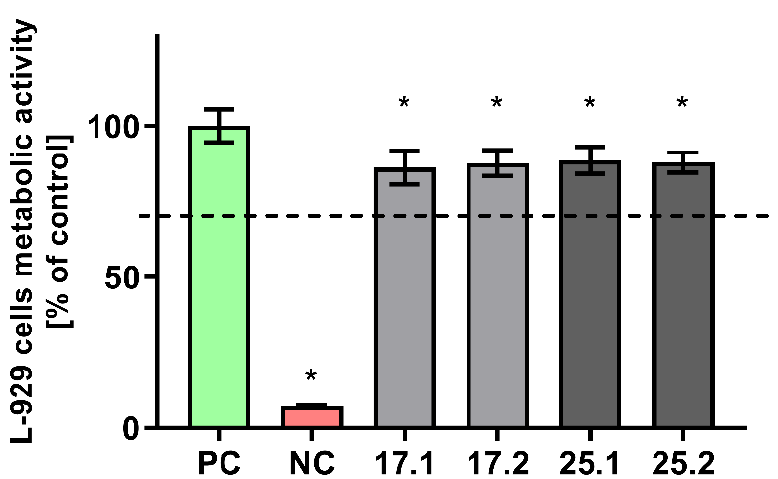
Figure 8. The viability of murine fibroblasts (L-929) after 24 h incubation with biocomposites, evaluated using MTT reduction test according to ISO-10993-5:2009. The positive control (PC) of the viability (100%) consisted of cells incubated without composites. The negative control (NC) of the viability (cells with significantly impaired metabolic activity) consisted of cells incubated with 0.3% hydrogen peroxide. The data are presented as mean ± SD, n = 6. The dashed line indicates the minimum level (70%) of the cells’ metabolic activity required to recognize the biomaterial as noncytotoxic at the in vitro level. * p values (<0.05) calculated in comparison to the NC. The viability of murine fibroblasts exposed to 17.1, 17.2, 25.1 and 25.1 biomaterials was at the levels of 86.24% ± 5.6%; 87.77% ± 4.24%; 88.6% ± 4.44%; 87.94% ±